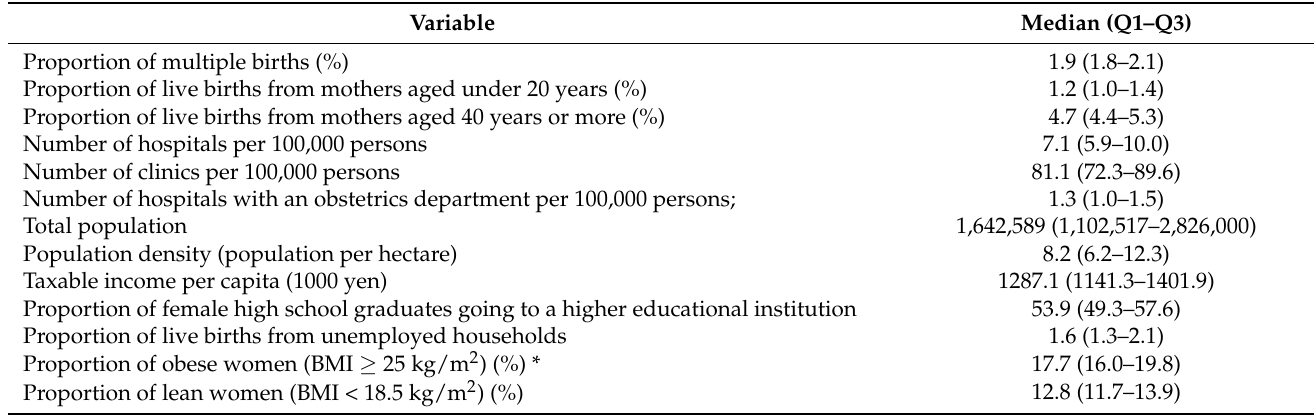
Table 5. Median (Q1–Q3) for each characteristic in the prefectures used in the analysis.